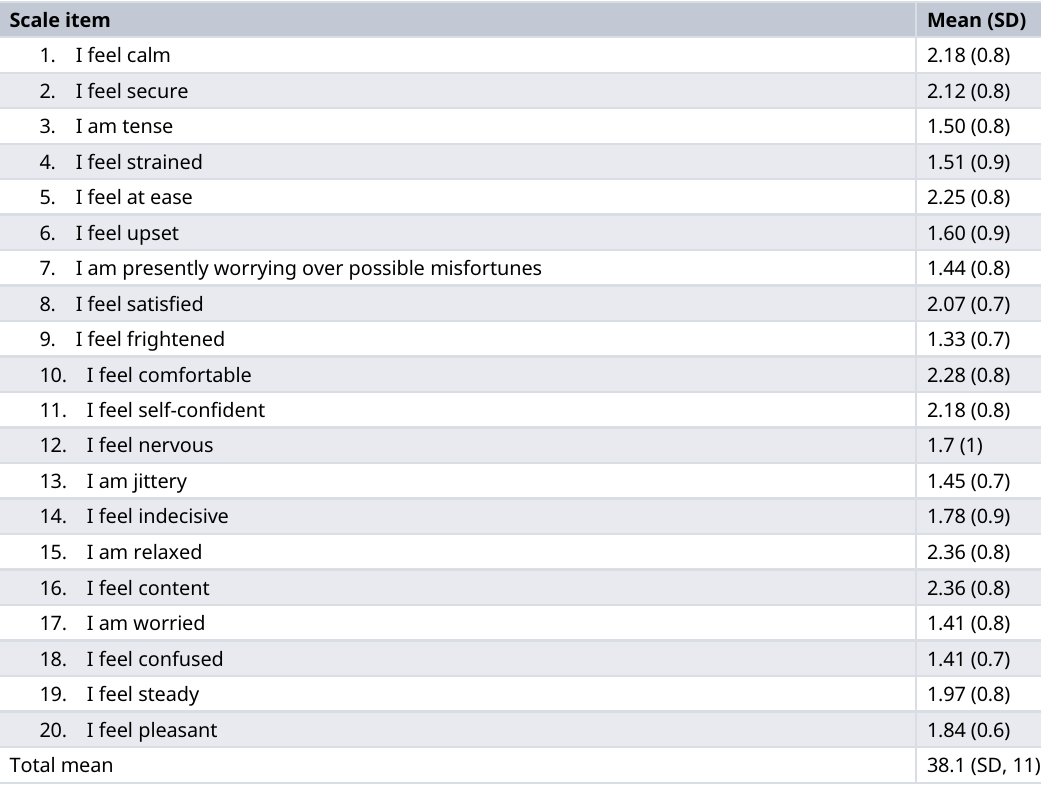
Table 2. Description of Mean Anxiety Score (State Anxiety Scale) (N =